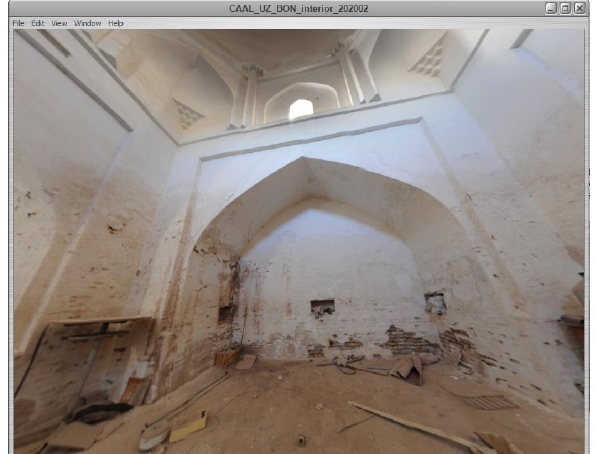
Figure 6. 360 degrees image of the interior of the Bogbonli Mosque. Source: authors.